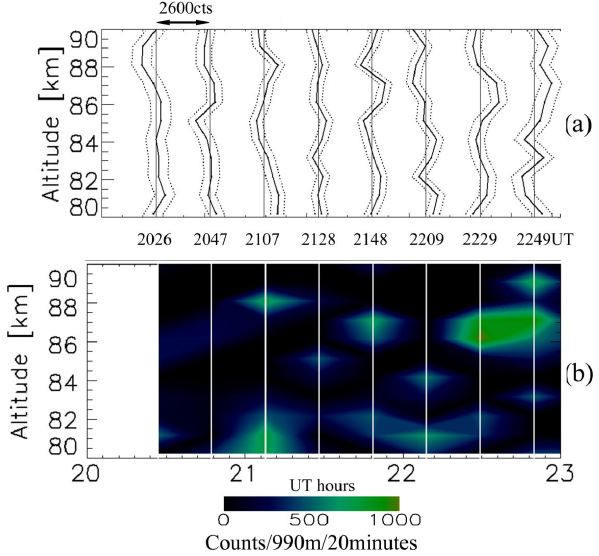
Fig. 2. (a) Count profiles of PMC signals observed by the Rayleigh Figure 2. (a) Count profiles of PMC signals observed by the Rayleigh lidar and (b) a 619 lidar and (b) a color contour plot of the counts. Each line plot shows color contour plot of the counts. Each line plot shows integrated counts over 20 min in 620 integrated counts over 20min in time (24000 shots) and 990m in altitude (66 bins). Solid and dotted lines in the upper panel represent time (24000 shots) and 990 m in altitude (66 bins). Solid and dotted lines in the upper 621 zero counts and 1-sigma error levels, respectively. The vertical solid line shown in the lower panel corresponds to the averaged sampling panel represent zero counts and 1-sigma error levels, respectively. The vertical solid line 622 time embedded between both panels. shown in the lower panel corresponds to the averaged sampling time embedded between 623 both panels. 624